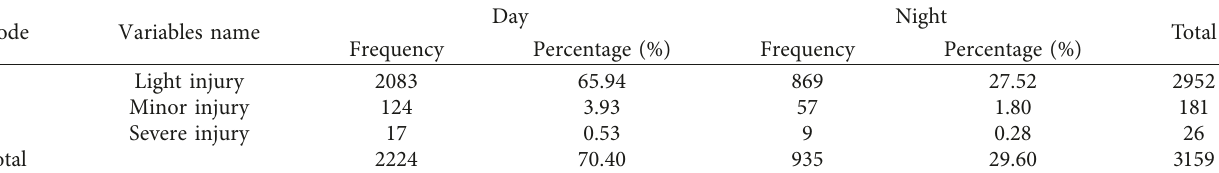
Table 2: Descriptive statistics of crash frequency.